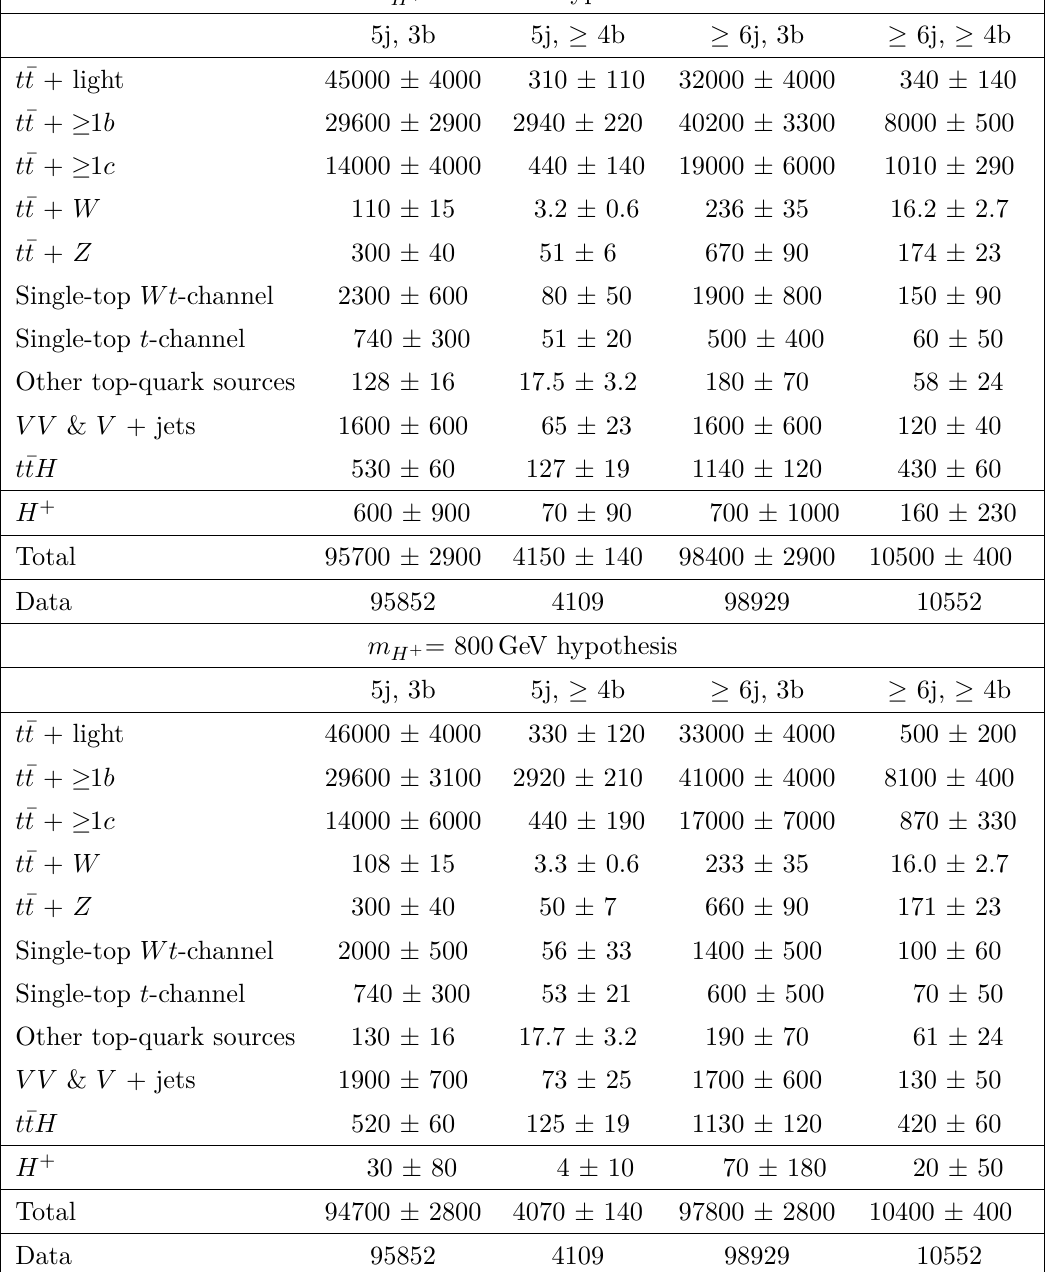
Table 4 . Event yields of the H + signal and SM background processes in the four analysis regions after the fit to the data under the H + mass ( m ) hypotheses of 200 GeV (top) and 800 GeV H + (bottom). The quoted uncertainties take into account correlations and constraints of the nuisance parameters and include both the statistical and systematic uncertainties. The signal yield uncer- tainty includes the uncertainty of the σ ( pp → tbH + ) × B ( H + → tb ) values fitted under the 200 or 800 GeV H + mass hypotheses. Negative correlations among t ¯ t + light, t ¯ t + ≥ 1 b and t ¯ t + ≥ 1 c mod- elling uncertainties can cause the uncertainty on the total yields to be smaller than on individual